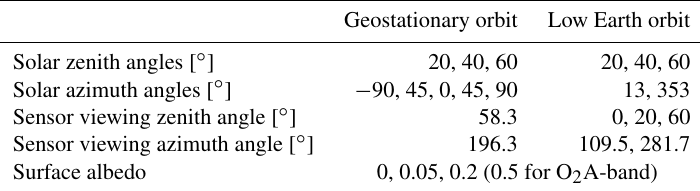
Table 2. Representative sun positions, sensor viewing directions and surface albedos included in the synthetic